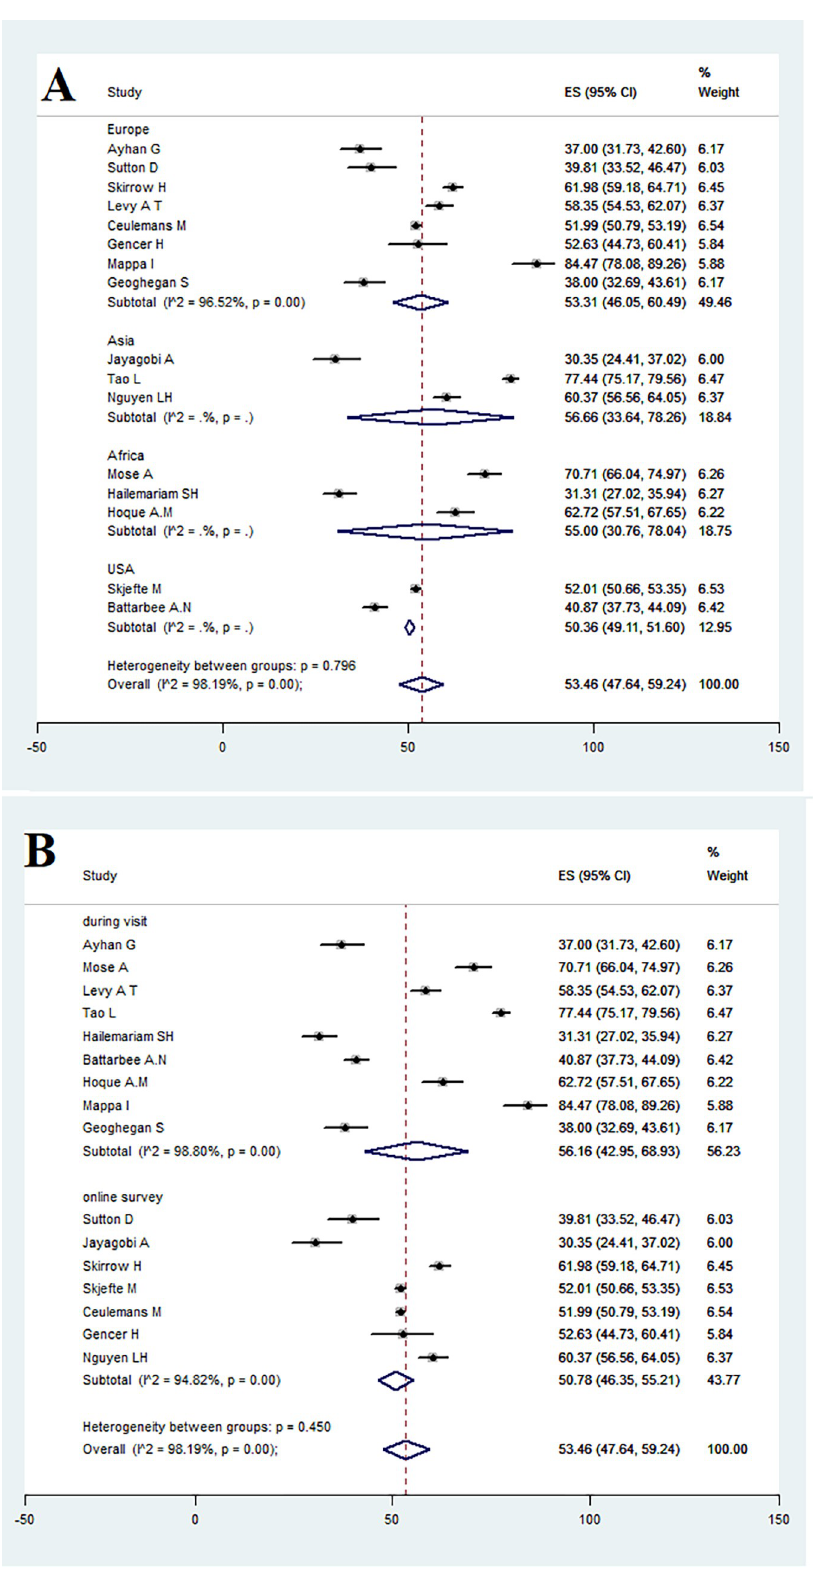
Fig 3. Subgroup analysis of acceptance of COVID-19 vaccine in pregnant women based on continent (A) and (B). https://doi.org/10.1371/journal.pone.0272273.g003 PLOS ONE | https://doi.org/10.1371/journal.pone.0272273 September 28,